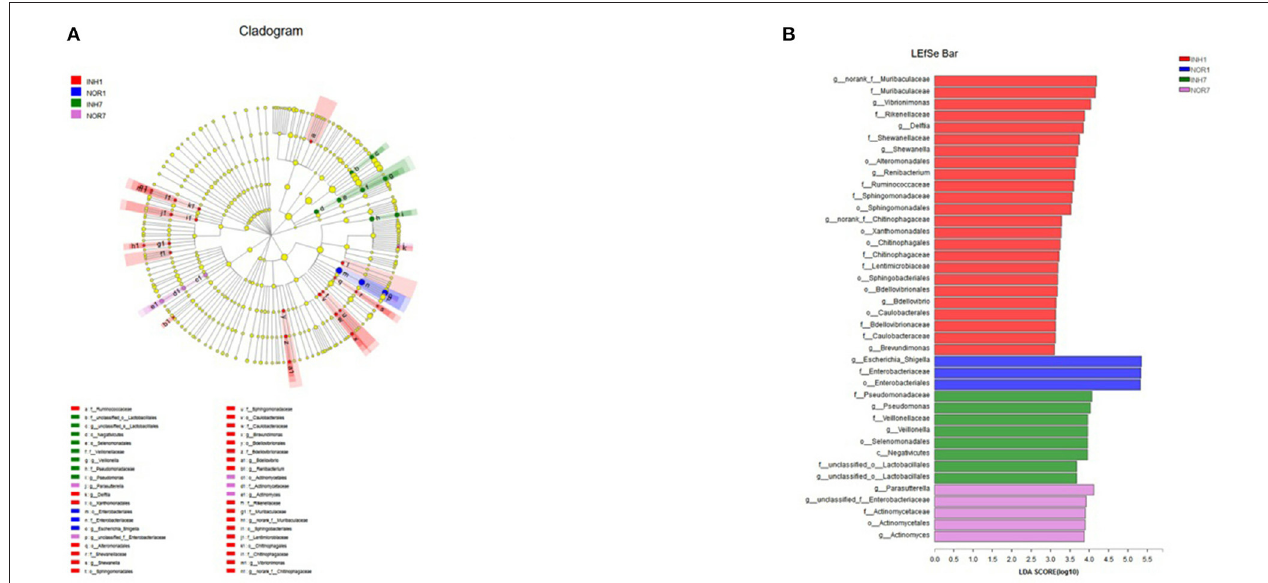
FIGURE 7 | (A) Different color nodes represent the microbial groups that are enriched significantly in the corresponding groups and have a significant influence on the difference between the groups. The light yellow nodes represent the microbial groups that have no significant difference in different groups or have no significant influence on the difference between groups. (B) The LDA discriminant histogram shows the counts of the microbial communities with significant effects in multiple groups based on the LDA score obtained through LDA analysis (linear regression analysis). The larger the LDA score is, the greater the influence of species abundance on the different effects.